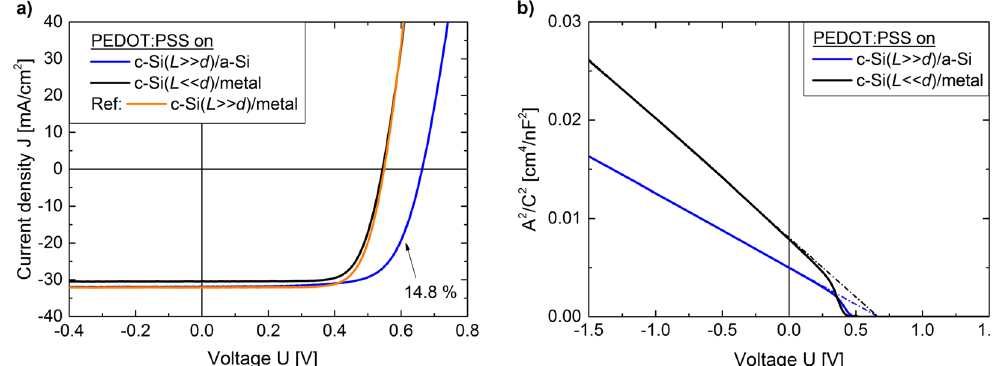
Figure 2. ( a ) Photovoltaic ( J - V ) and ( b ) Capacitance ( C - V ) response of c-Si based solar cells with a PEDOT:PSS front contact. Comparing PEDOT:PSS/c-Si/a-Si(i)/a-Si(n + )/ITO/Ti/Ag solar cells based on Si wafers with a low minority carrier diffusion length L compared to its thickness d (L ≫ d) to PEDOT:PSS/Si/metal solar cells based on lower quality Si wafer (L ≪ d). As a reference it is shown that the a-Si back contact does not lead to an increase in performance of the hybrid solar cell when applied to the lower quality wafer. All extracted solar cell parameters are collected in Table 1.